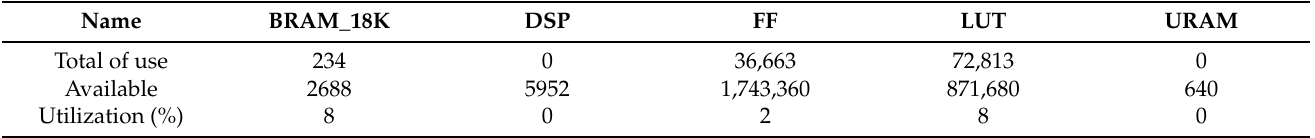
Table 2. Utilization for the PL hardware